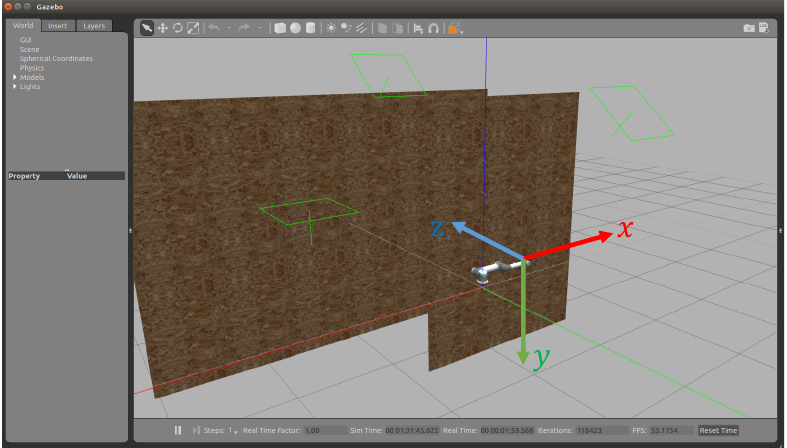
Figure 8. Simulated environment (y points down).The camera is equipped on the end-effector of a robot arm such that we can control the robot arm to move the